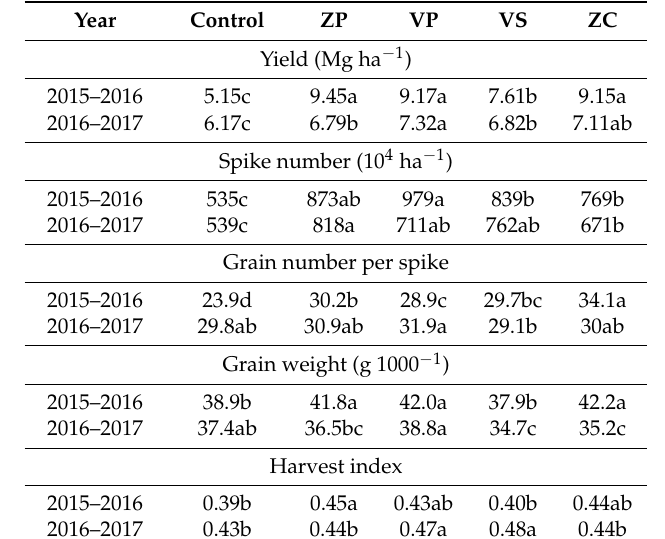
Values represent the mean of three replicates. Different letters (a, b, and c) denote significant differences ( p < 0.05) within a row as determined by Duncan’s multiple comparison test. Table 3. Wheat yield, yield components, and harvest index as affected by the treatments, year, and interaction between treatments and year. All data for the ANOVA come from Table 2. ANOVA Sum of Squares Degrees of Freedom Mean of the